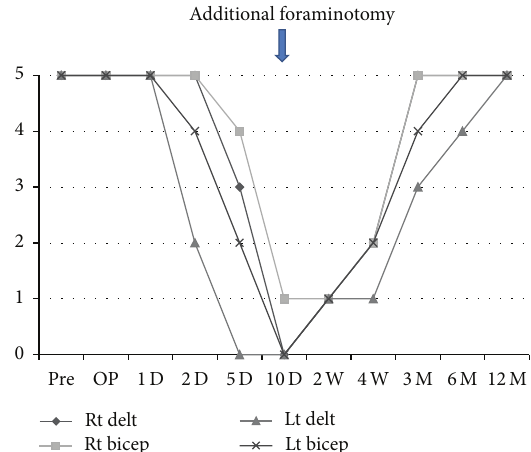
Figure 4: A timeline based graph for the changes of muscle strength (MMT) in bilateral deltoid and biceps. The palsy started on the left side in which foraminal stenosis is more severe on the second day after laminectomy and fusion and then extended on to the right side on the fifth day. Paresis gradually deteriorated and manual muscle testing finally became of grade 0-1 at 10 days after surgery, on which day we performed additional foraminotomy. Muscular contraction was seen at 2 weeks after foraminotomy and gradually improved. The weakness of left deltoid remained. Finally, complete recovery was achieved in a year after additional